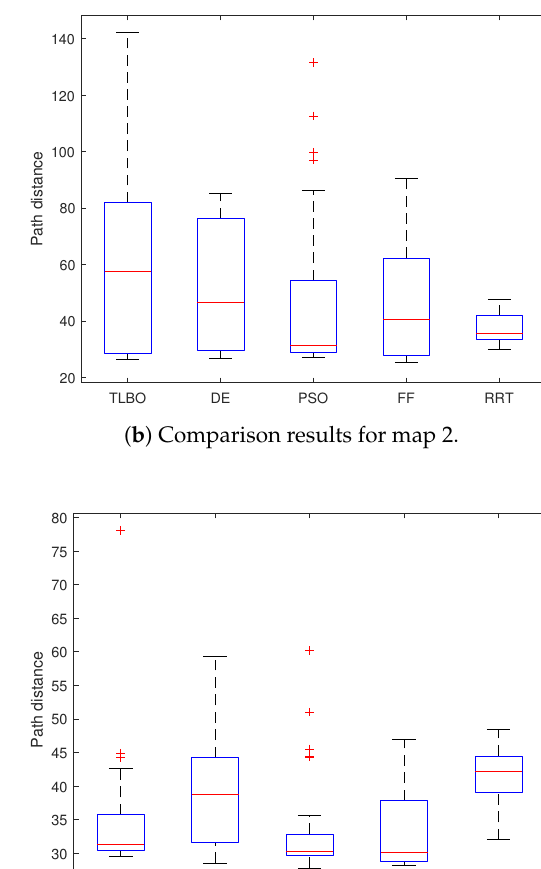
( c ) Comparison results for map 3. ( d ) Comparison results for map 4. Figure 14. Comparison results for four experimental maps and for the five proposed methods.